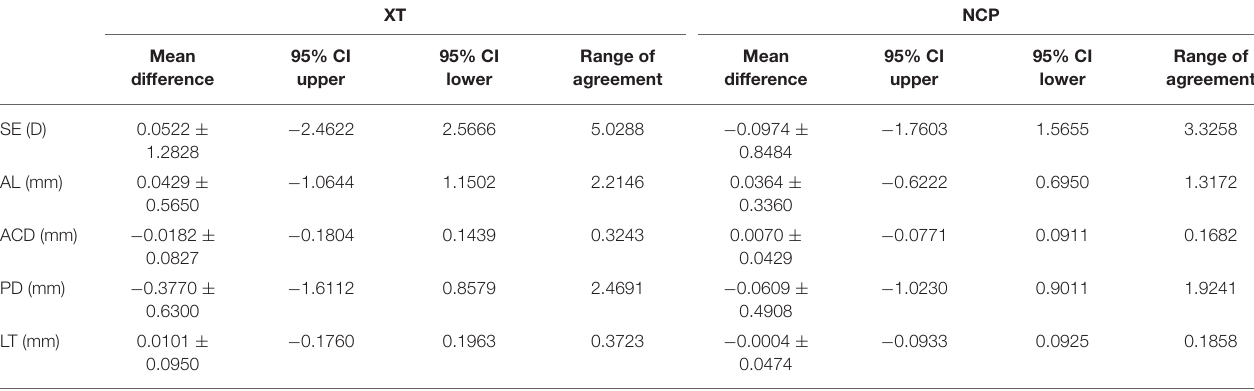
TABLE 3 | Summary of the inter-ocular agreement of biometric parameters between concomitant exotropia and control